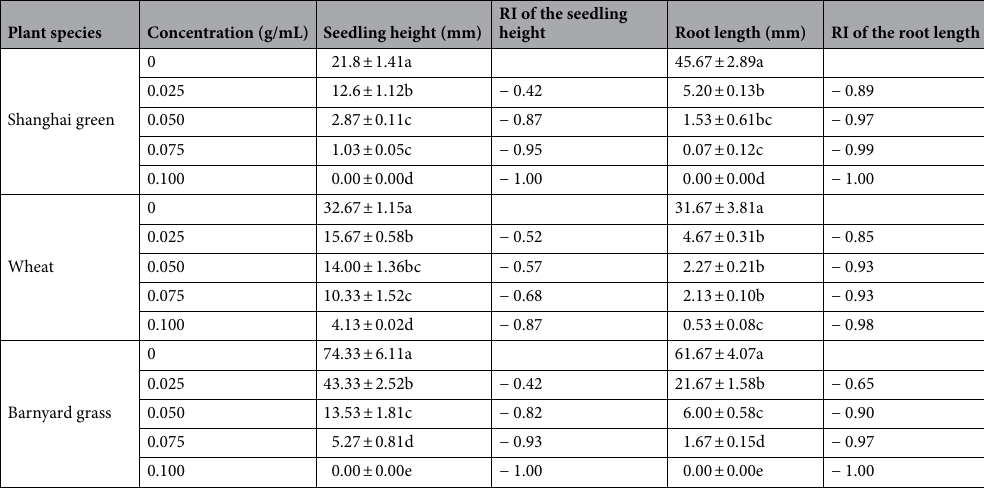
Table 2. Effects of the water extract from leaves of Flaveria bidentis on the seedling height and root length of three plants. Data are shown as the mean ± standard deviation. Different letters in the same column for each treatment indicate significant differences at the P < 0.05 level, while the same letter indicates no significant difference at the P < 0.05 level.